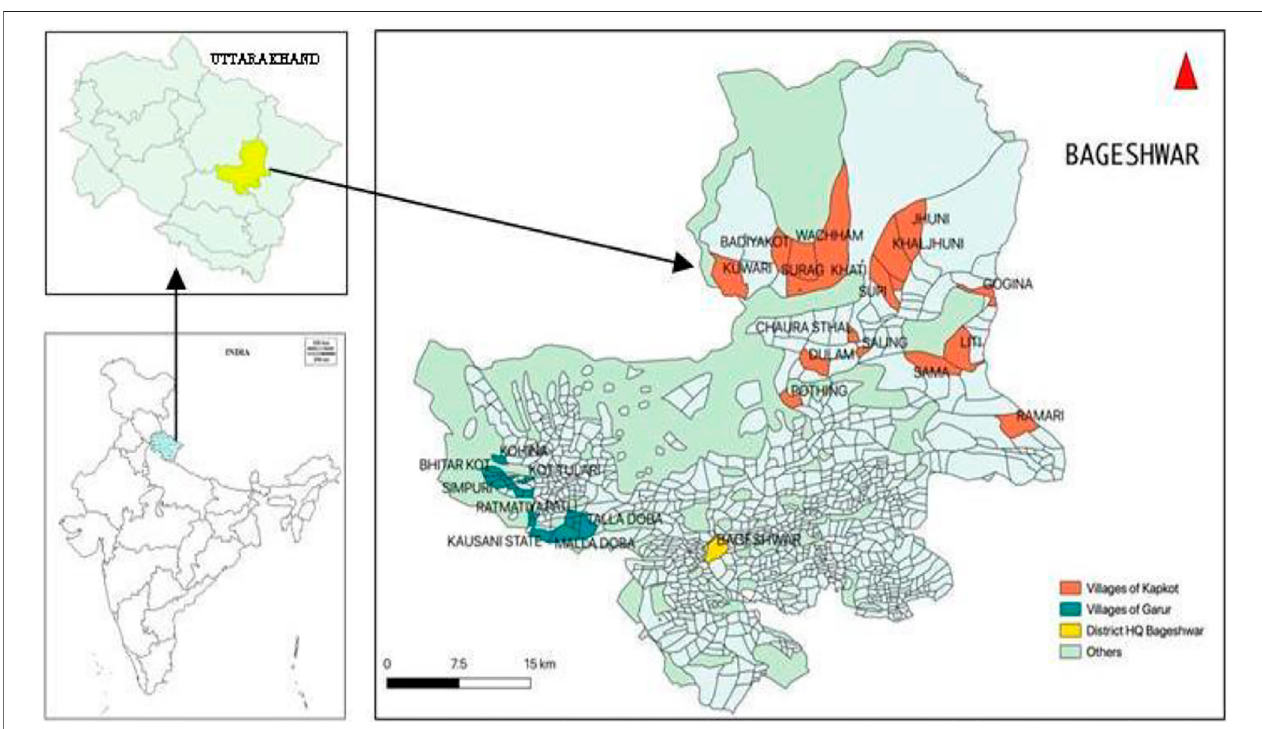
FIGURE 1 | Study area and villages in Garur and Kapkot Blocks of Bageshwar, Uttarakhand, India.